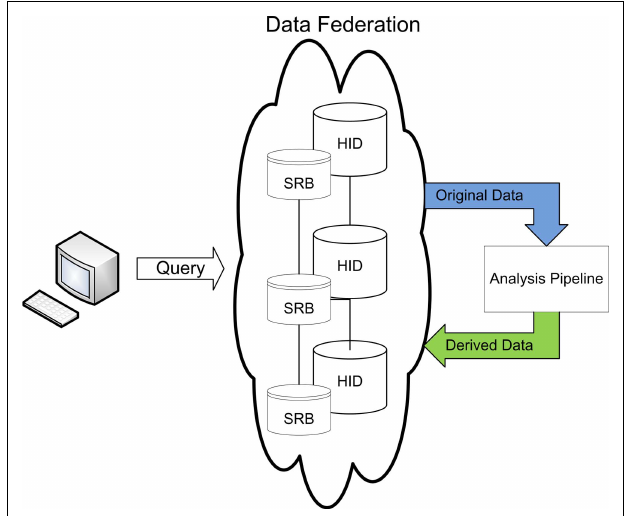
FIGURE 2 | FBIRN data management discovery and analysis workfl